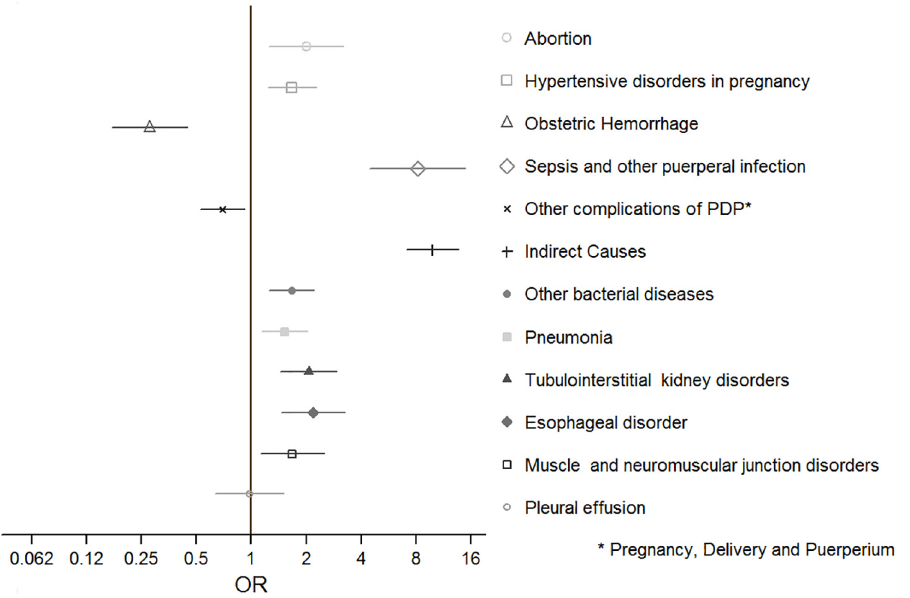
Fig 3. Odds ratios (OR) and 95% confidence intervals for causes related to late maternal deaths (deaths occurring after 42 days but before 365 days after the end of pregnancy). Mexico, 2010 – 2013.